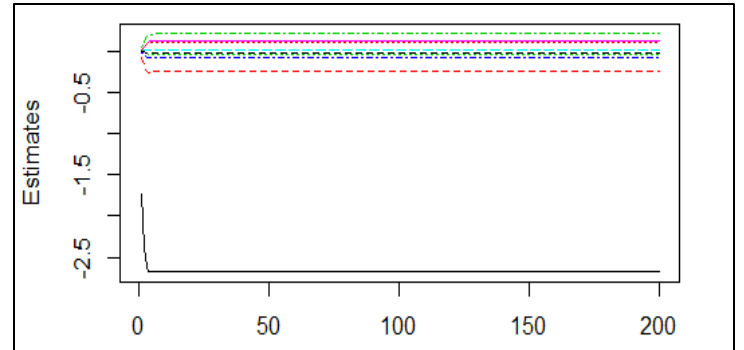
Figure 1. The magnitude of all the estimates in the D = 200 iterations. The different colors indicate each of the coefficients in the XGBoost iteration.